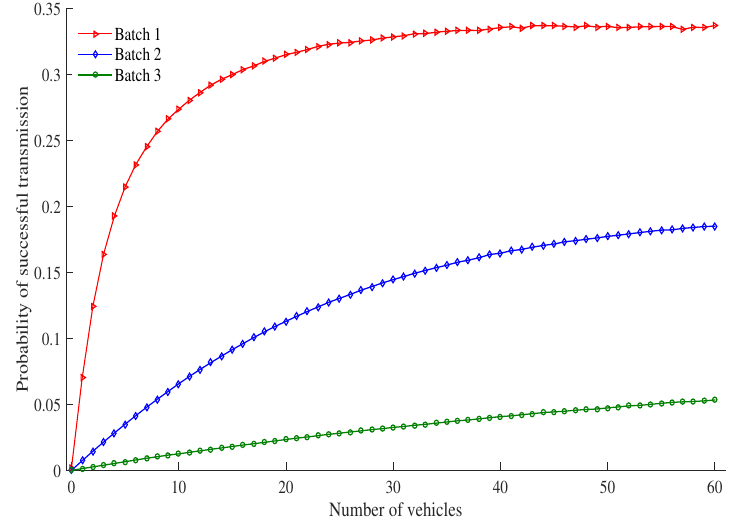
Figure 7. Probability of successful transmission vs number of